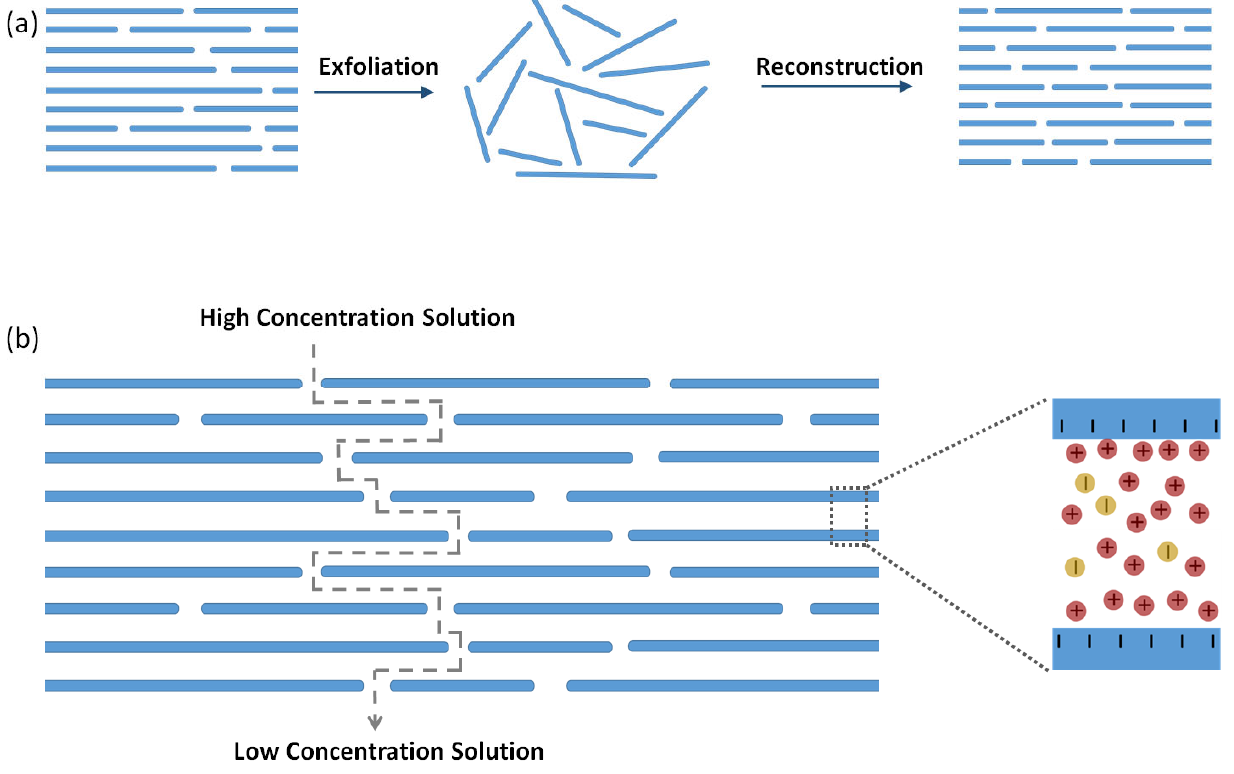
Figure 4. Schematic representation of ( a ) the exfoliation–reconstruction approach to fabricating layered membranes with 2D pores, ( b ) the selective ion transport through 2D pores due to the overlap of the electric double layer at the interlamellar gap of the nanosheets.